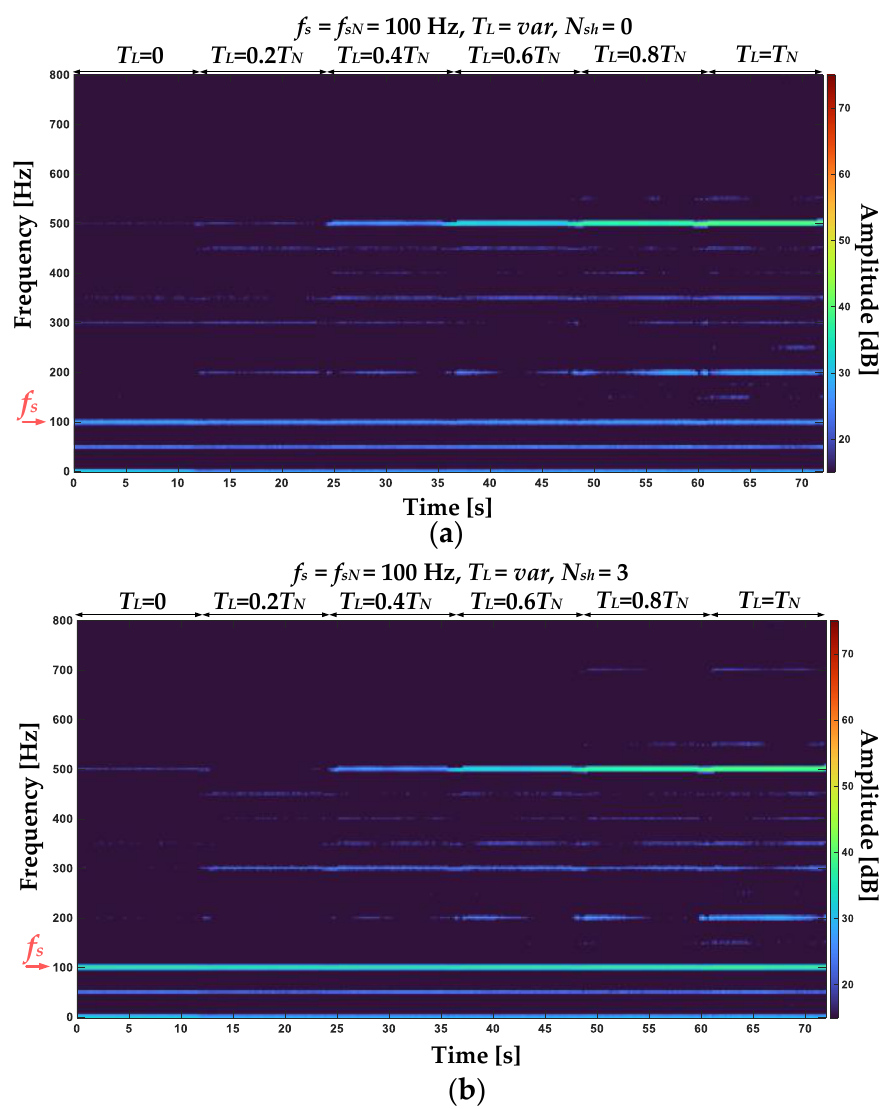
Figure 8. STFT spectrograms of the negative sequence stator current component for ( a ) undamaged stator winding and ( b ) 3 shorted turns in phase A ( T L = var, f s = 100 Hz).